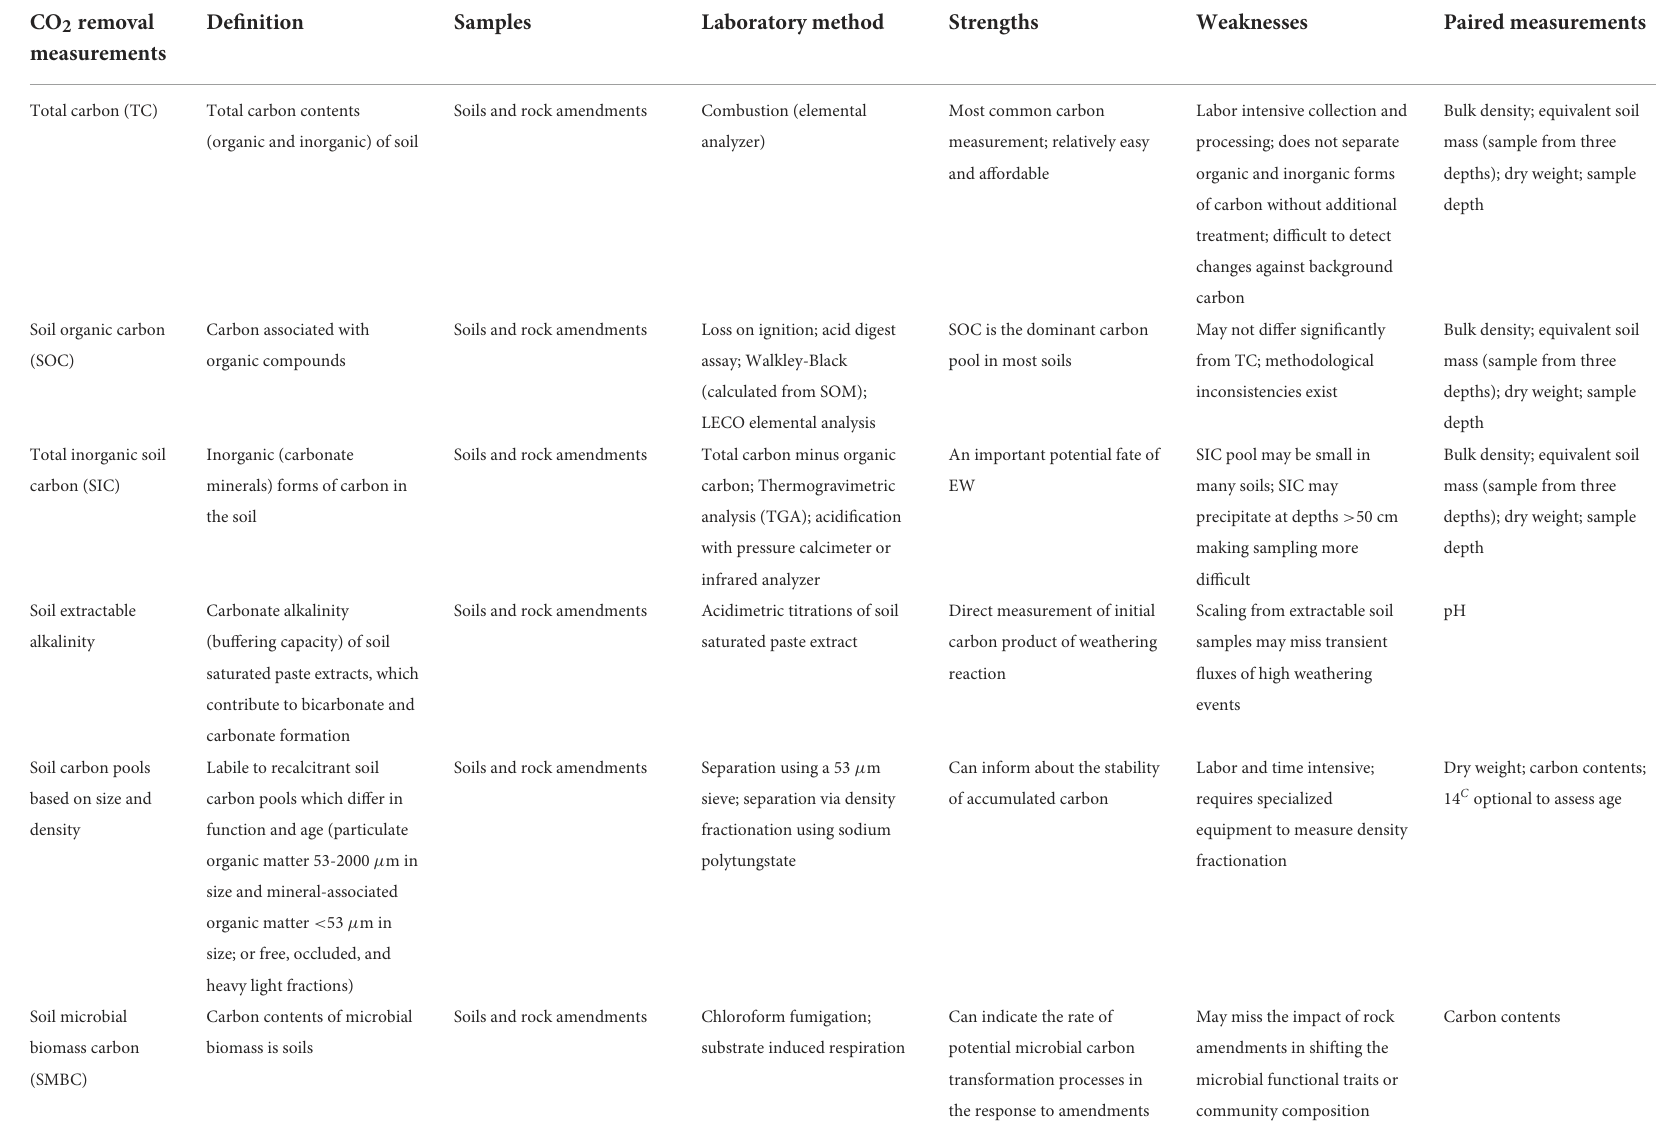
TABLE 4 Common carbon measurements for determining the CO 2 removal capacity of enhanced weathering in agronomic settings, inclusive of measurement definition, sample type, common methodology, strengths and weakness of each approach, and supplemental measurements best paired with each carbon